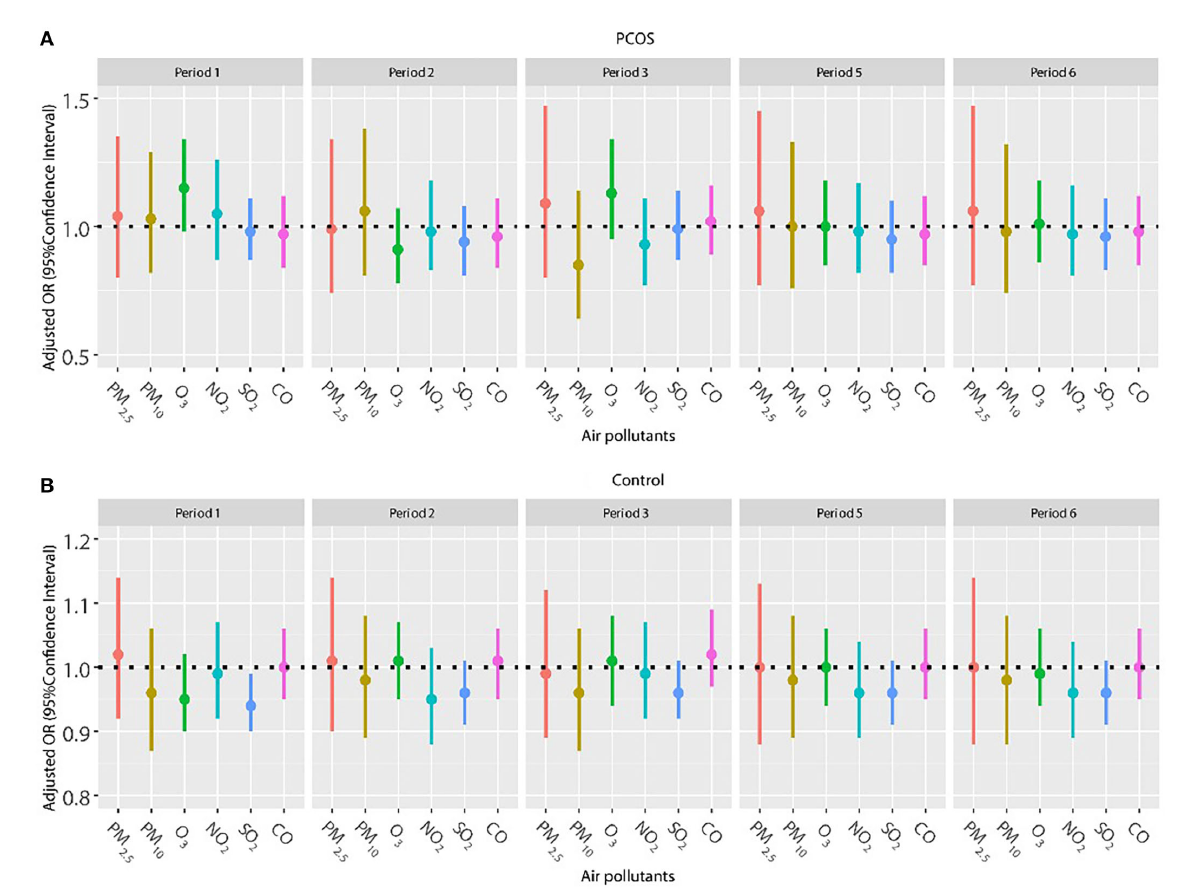
FIGURE5 (A,B) Association between ambient air pollution exposure and live birth rate among PCOS and non-PCOS women aged less than 35 years. Note: Results showed in bold indicated statistically significant associations. PM 2.5 , particulate matter ≤ 2.5 µ m, µ g/m 3 ; PM10, particulate matter ≤ 10 µ m, µ g/m 3 ; NO 2 , nitrogen dioxide, µ g/m 3 ; SO 2 , sulfur dioxide, µ g/m 3 ; CO, carbon monoxide, mg/m 3 ; O 3 , ozone, µ g/m3. Model adjusted for BMI, education level, infertility type (primary or secondary infertility), infertility duration, infertility cause (female factor, male factor, both, and unexplained factor), type of embryo transfer (fresh or frozen embryo transfer), number of embryos transferred (one or two), fertilization method (IVF, ICSI or IVF + ICSI), endometrial thickness, and season of embryo transfer (spring, summer, autumn, or winter). Period 1, 2, 3, 5, 6 indicate the exposure windows shown in Figure